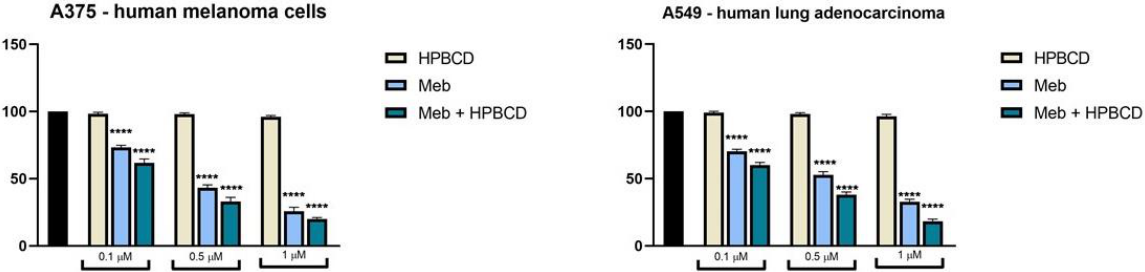
Figure 8. In vitro viability evaluation of MEB, HPBCD, and MEB + HPBCD (0.1, 0.5, and 1 μM) in A375 and A549 cells at 72 h post-stimulation by the MTT assay. The results are expressed as the cell viability percentage normalized to control cells (unstimulated). The data represent the mean values ± SD of three independent experiments performed in triplicate. One-way ANOVA analysis was applied to determine the statistical differences in rapport with control cells followed by Dunnett’s multiple comparisons post-test (**** p < 0.0001).